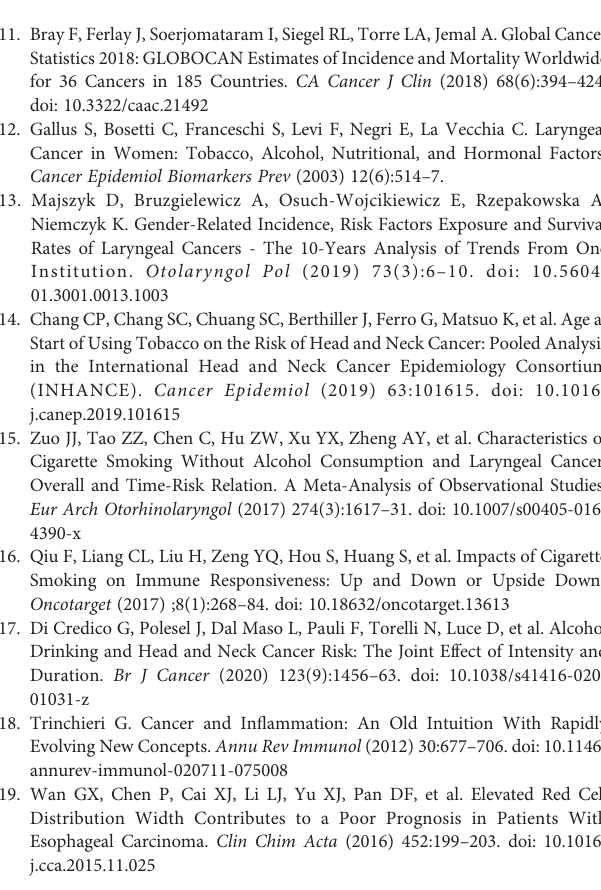
Supplementary Figure 1 | The coef fi cients of multivariate logistic regression analysis. Supplementary Table 1 | The coef fi cients of Lasso regression